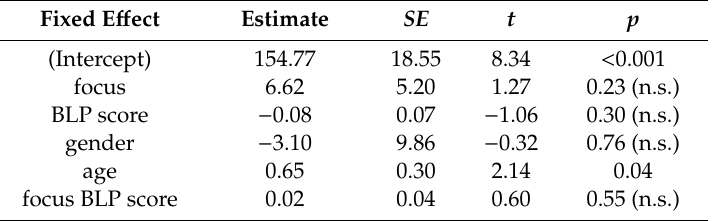
Table 3. Results of the mixed-e ff ects model for stressed syllables in subject position ( N = 864).